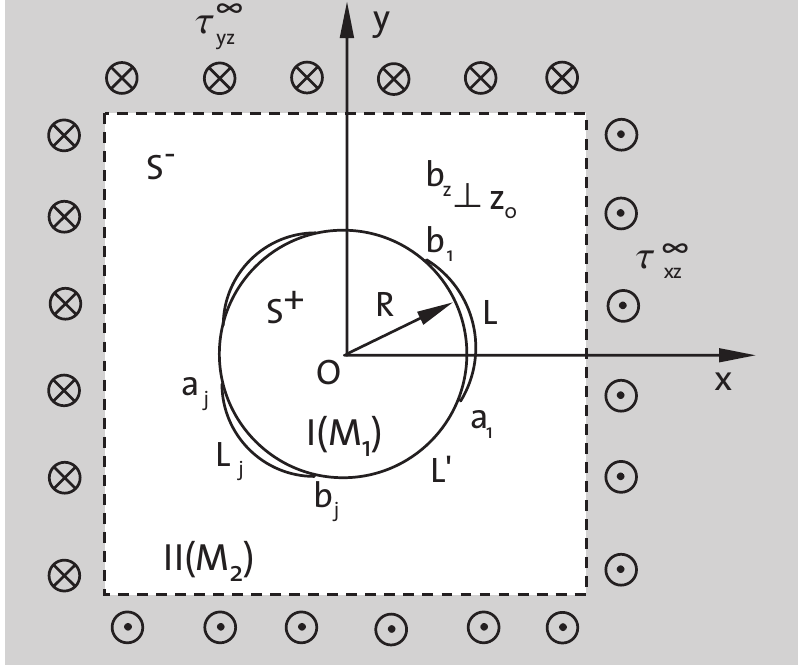
Figure 1: Interaction of a screw dis- location and piezoelectric inhomogeneity with inter- facial cracks